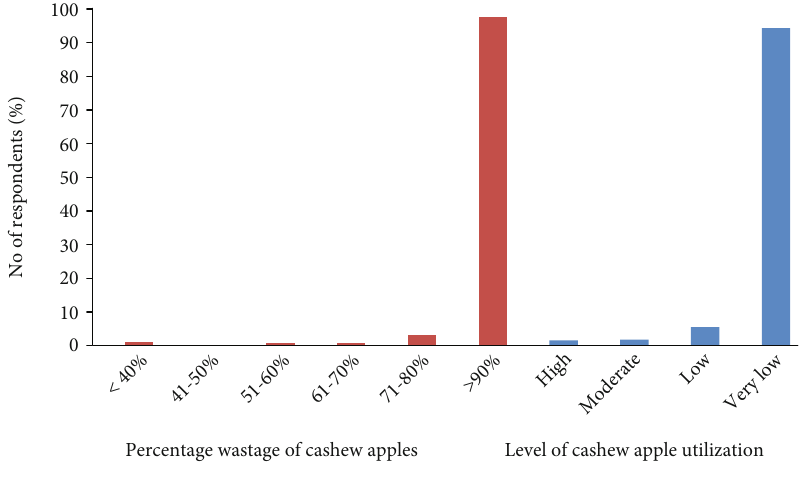
Figure 5: Percentage wastage and utilization of cashew apples in